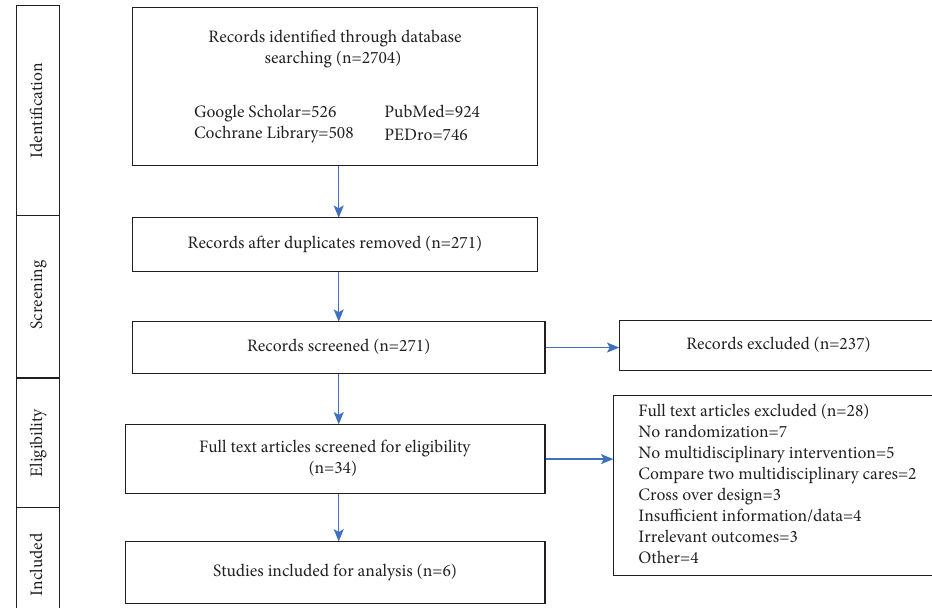
Figure 1: PRISMA flowchart describing the search